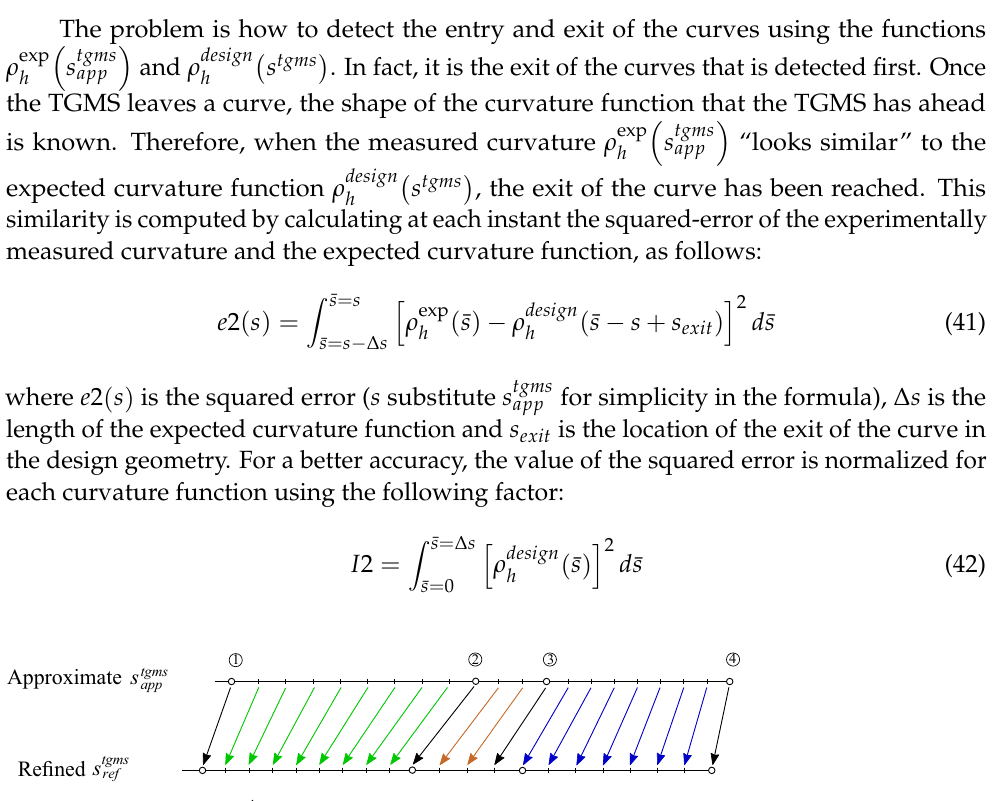
Figure 10. Odometry algorithm.